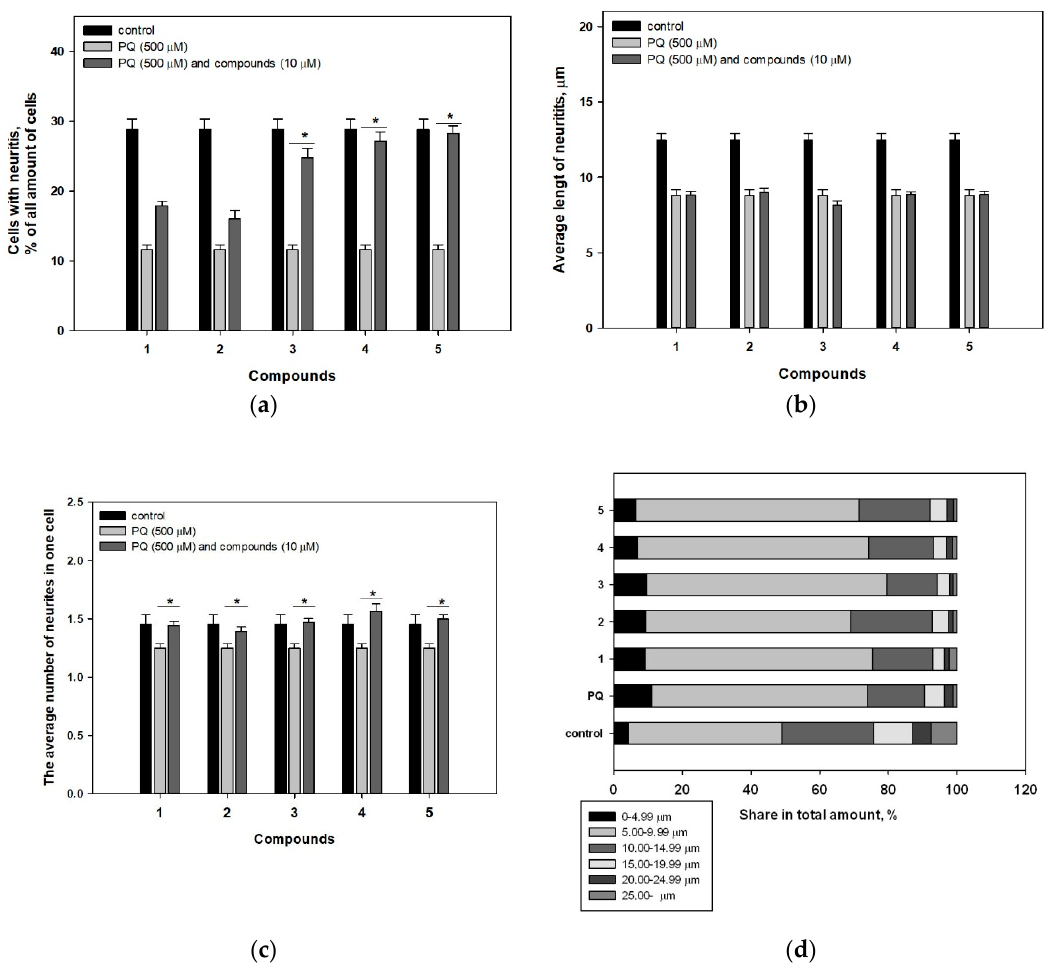
Figure 6. Influence of compounds 1 – 5 on neurites outgrowth in PQ-treated Neuro-2a cells. The neurites-bearing cell amount ( a ), average length of neurites ( b ), and average number of neurites ( c ) per cell, and the proportion of neurites of different lengths in the total number ( d ) are presented. Each bar represents the mean ± SEM of three independent replicates. (*) indicates p < 0.05 versus PQ-treated cells. The difference between control and PQ-treated cells was considered significant ( p < 0.05).